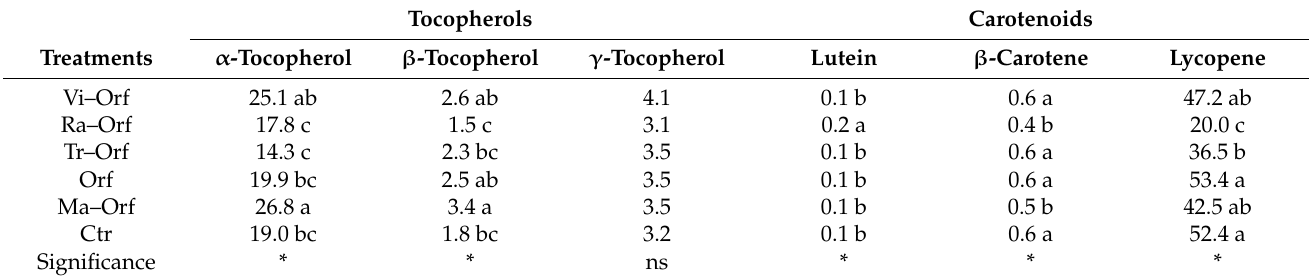
Table 4. Effects of treatments on tocopherols and carotenoids content in tomato fruits ( µ g g − 1